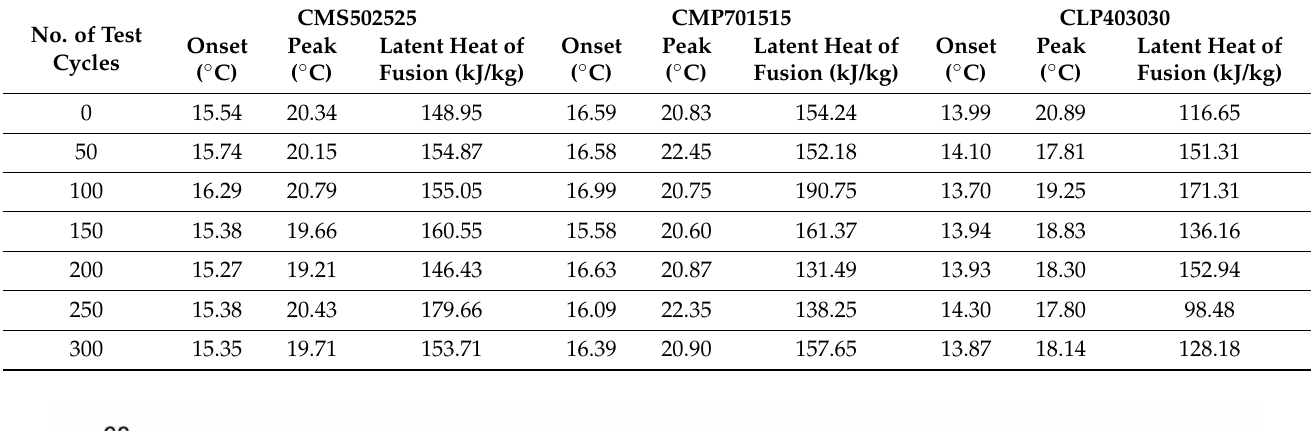
Table 5. Latent heat of fusion and melting temperature of developed materials with test cycles (CMS502525, CMP701515, CLP403030).